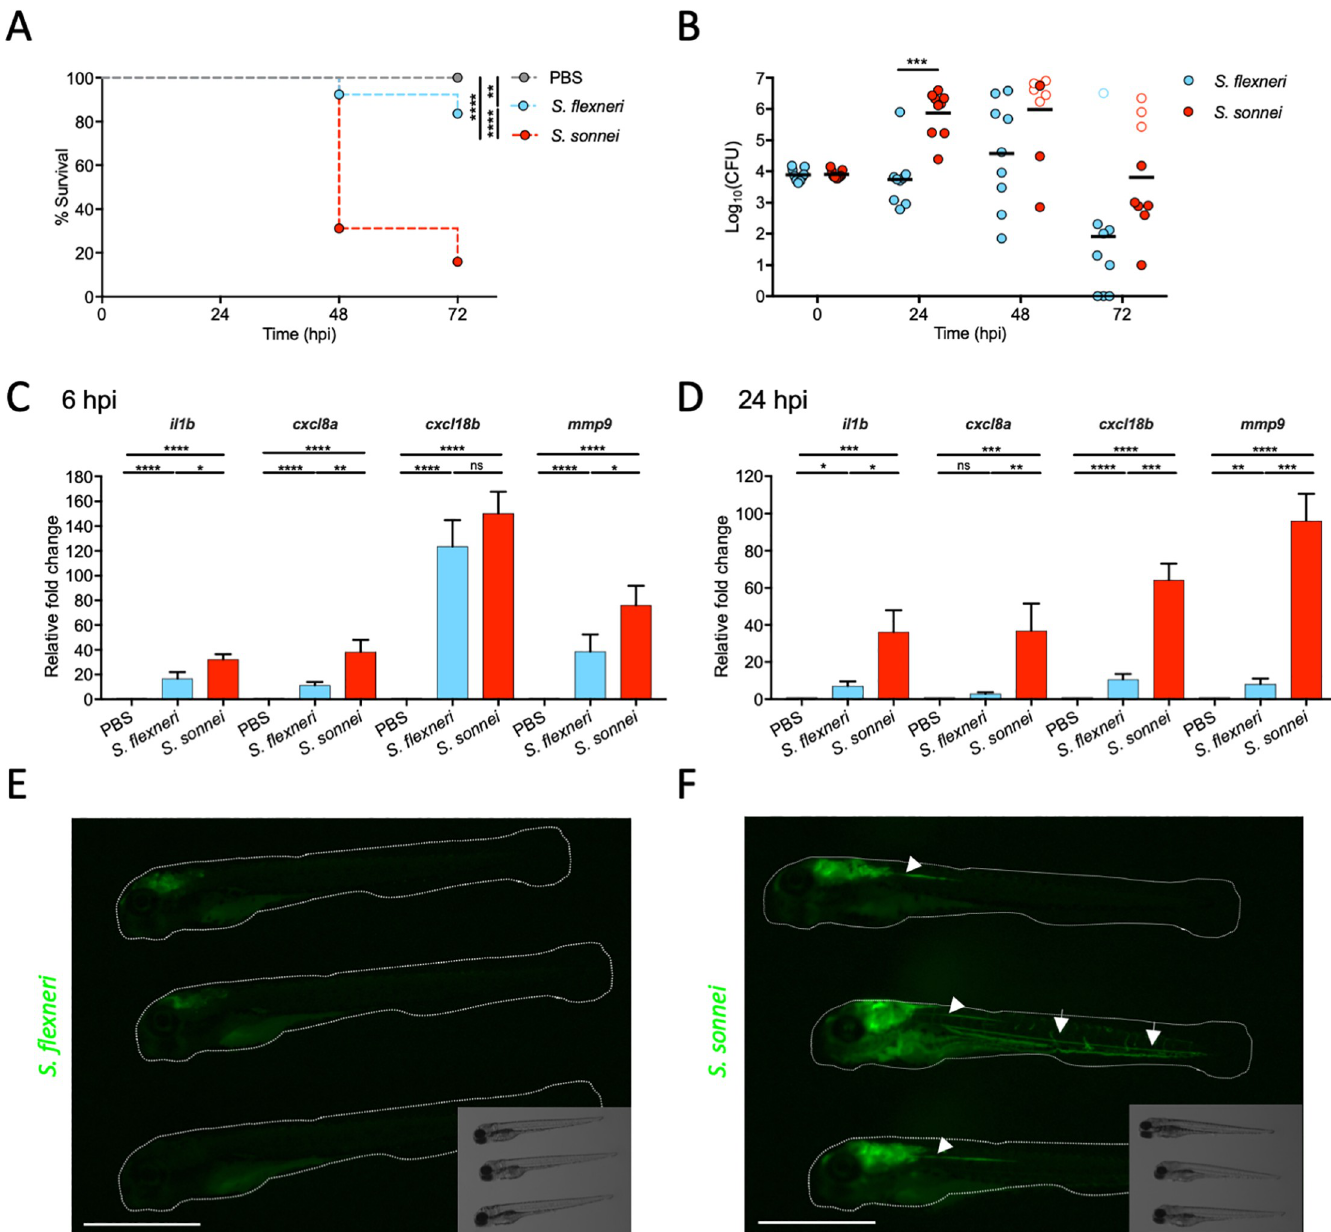
Fig 1. S . sonnei is more virulent than S . flexneri in a zebrafish infection model. A,B. S . sonnei is more virulent than S . flexneri in vivo . Survival curves (A) and Log 10 - transformed CFU counts (B) of larvae injected in the hindbrain ventricle (HBV) with PBS (grey), S . flexneri (blue) or S . sonnei (red). Experiments are cumulative of 3 biological replicates. In B, full symbols represent live larvae and empty symbols represent larvae that at the plating timepoint had died within the last 16 hours. Statistics: Log-rank (Mantel-Cox) test (A); unpaired t-test on Log 10 -transformed values (B); �� p < 0.0021; ��� p < 0.0002; ���� p < 0.0001. C,D. S. sonnei elicits a stronger inflammatory signature than S. flexneri in vivo . Quantitative real time PCR for representative inflammatory markers were performed on pools of 20 HBV injected larvae collected at 6 (C) or 24 (D) hpi with PBS (grey), S . flexneri (blue) or S . sonnei (red). Experiments are cumulative of 4 biological replicates. Statistics: one-way ANOVA with Sidak’s correction on Log 2 -transformed values; ns, non-significant; � p < 0.0332 �� p < 0.0021; ��� p < 0.0002; ���� p < 0.0001. E,F. S. sonnei can disseminate from the injection site . Representative images of three GFP-labelled S . flexneri -infected (E) or S. sonnei -infected (F) larvae at 24 hpi. In D, arrows indicate dissemination in the blood circulation; arrowheads indicate dissemination in the neuronal tube. Scale bars = 1